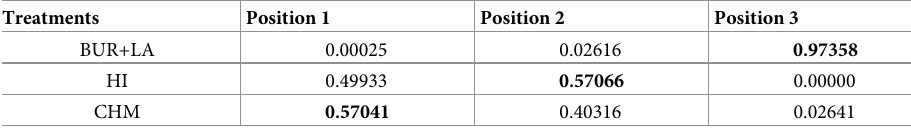
ments and local anesthesia (BUR+LA), restorative treatment using rotary instruments (BUR),